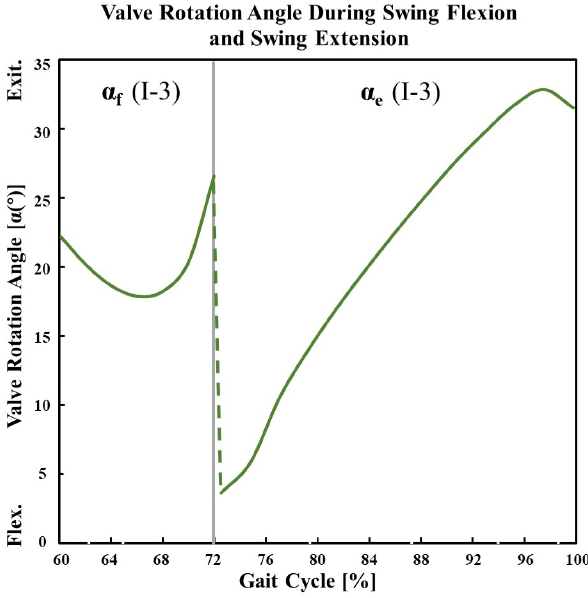
Figure 11. Valve rotation angle during swing phase.